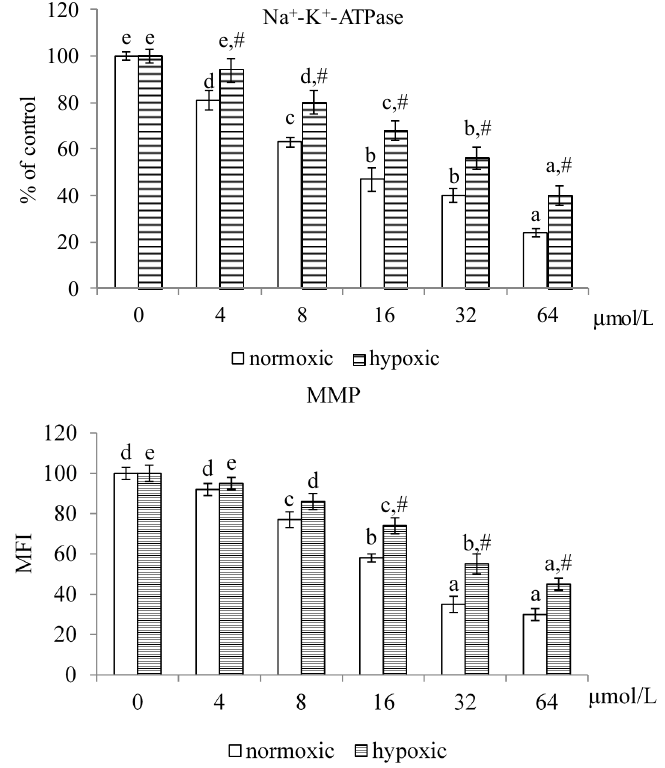
respectively. Compared with hypoxic conditions, MA at 8–64 μ mol/L under normoxic conditions led to greater caspase-8, cytochrome c and AIF expression ( p < 0.05). Figure 3. Effects of MA at 0, 4, 8, 16, 32 or 64 μ mol/L upon Na + -K + -ATPase activity and mitochondrial membrane potential (MMP) in A549 cells under normoxic and hypoxic conditions. Data are mean ± SD ( n = 10). a–e Means among bars in the same condition without a common letter differ, p < 0.05. # Means significantly different from normoxic conditions at the same dose at p < 0.05.